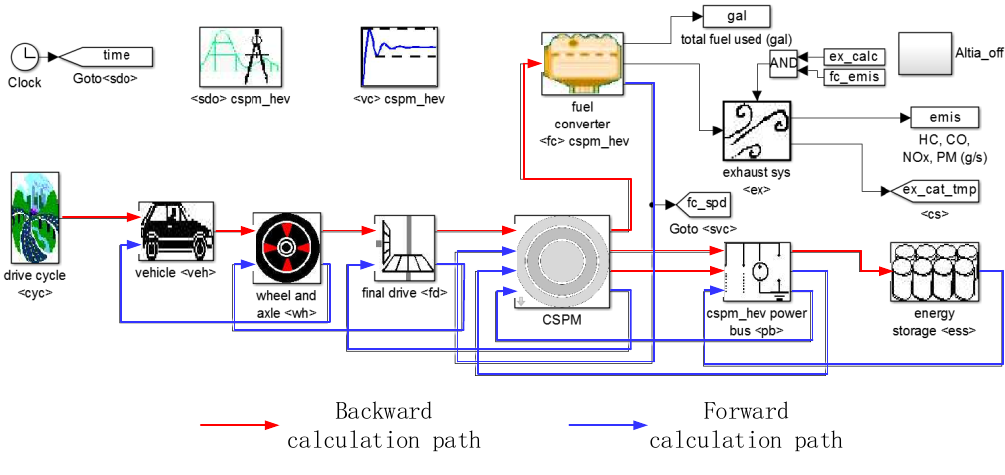
Figure 8. Simulation model of CSPM-HEV. Table 1. Simulation parameters of CSPM-HEV.